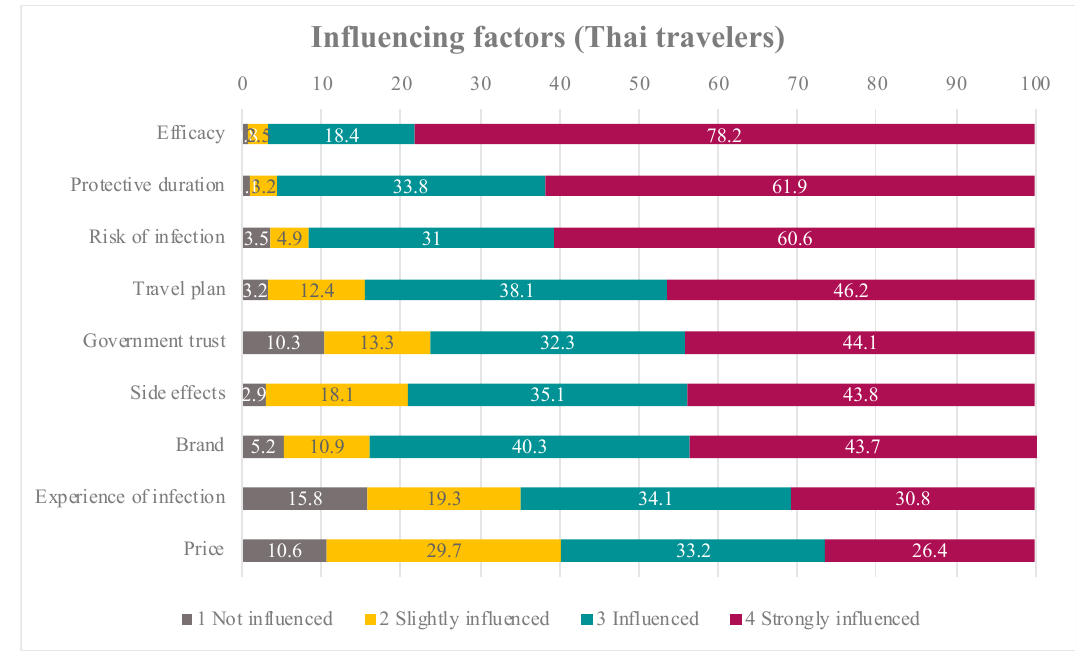
Figure 3. The percentages of influencing factors among Thai travelers.